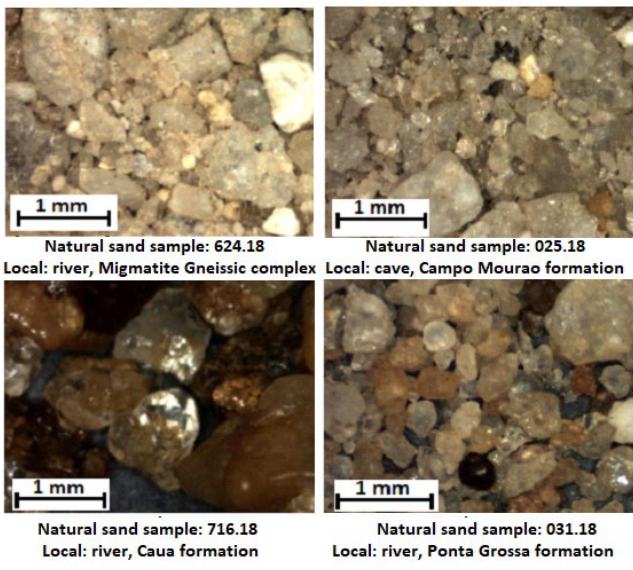
Figure 1. Images, by optical microscopy, of some natural sands from the rock formations highlighted in Table 1.